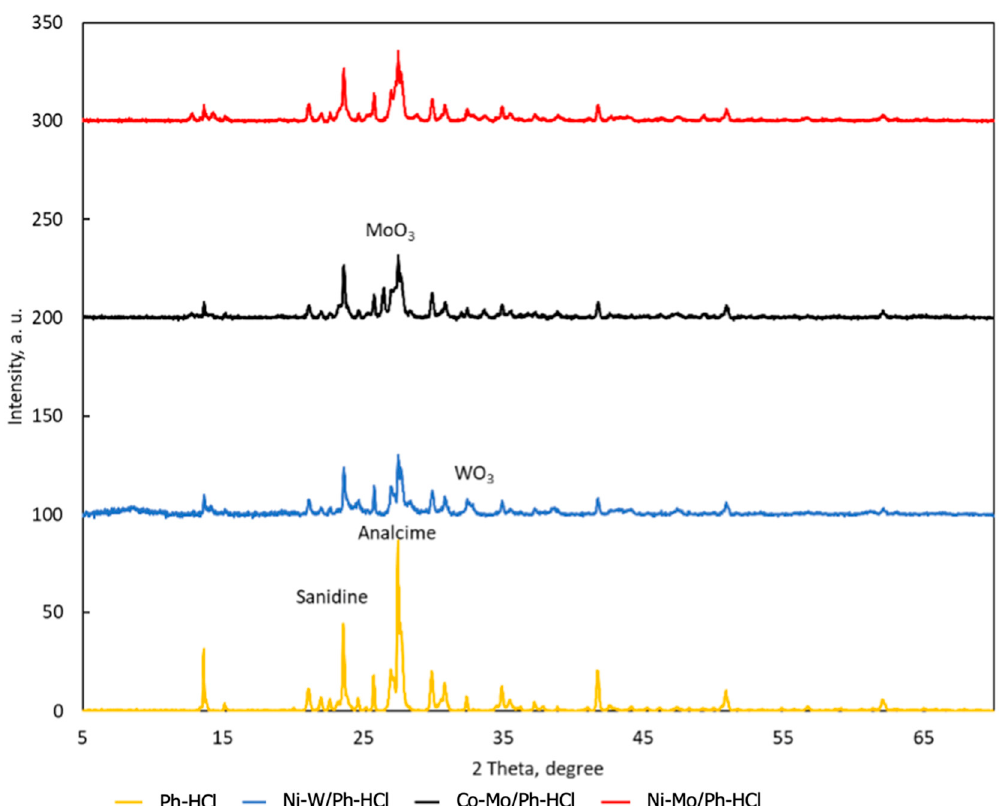
Figure 3. XRD diffraction patterns of Ph-HCl support and catalyst samples (Co-Mo/Ph-HCl, Ni- Mo/Ph-HCl, Ni-W/Ph-HCl) [25].